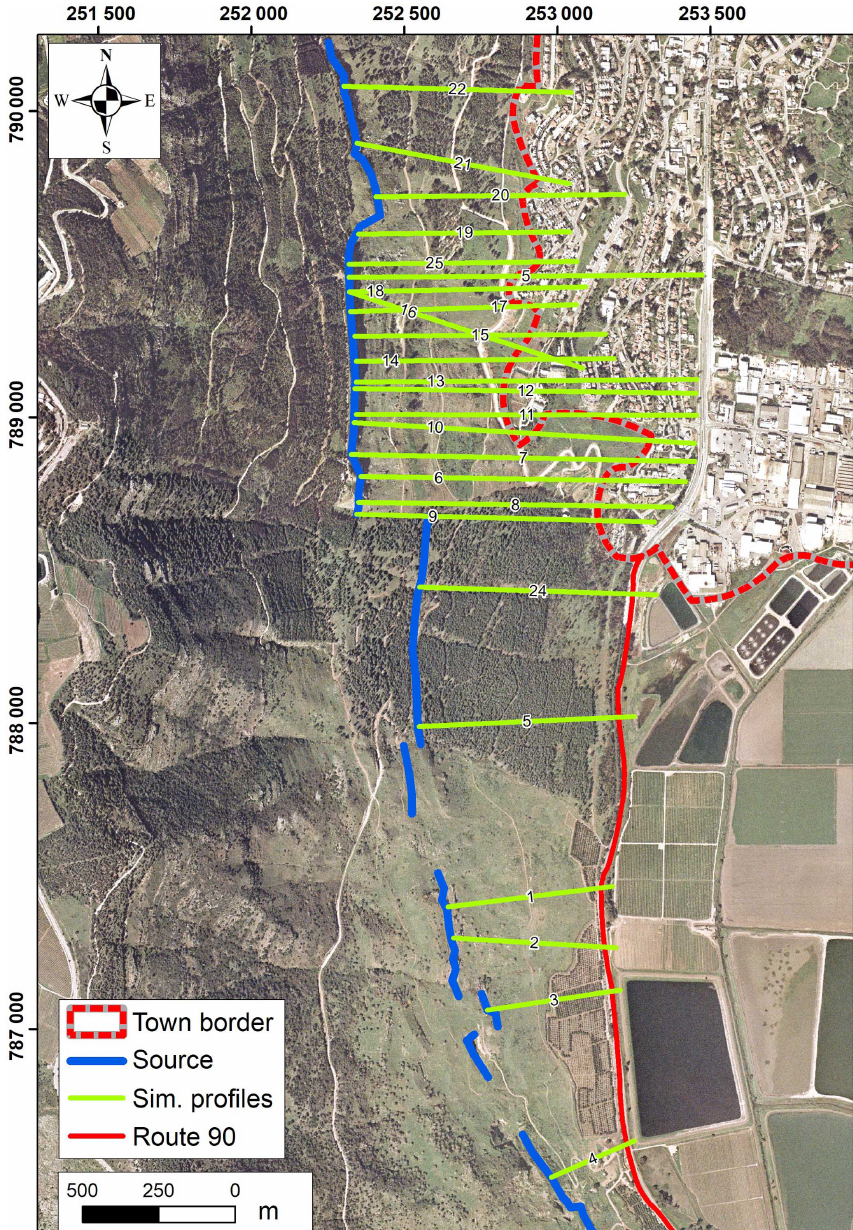
Figure 4. Location of 25 simulation profiles of rockfall trajectories. Fault traces are from Sneh and Weinberger (2003a). The source for the rockfalls (Ein El Assad Formation) is marked with the blue